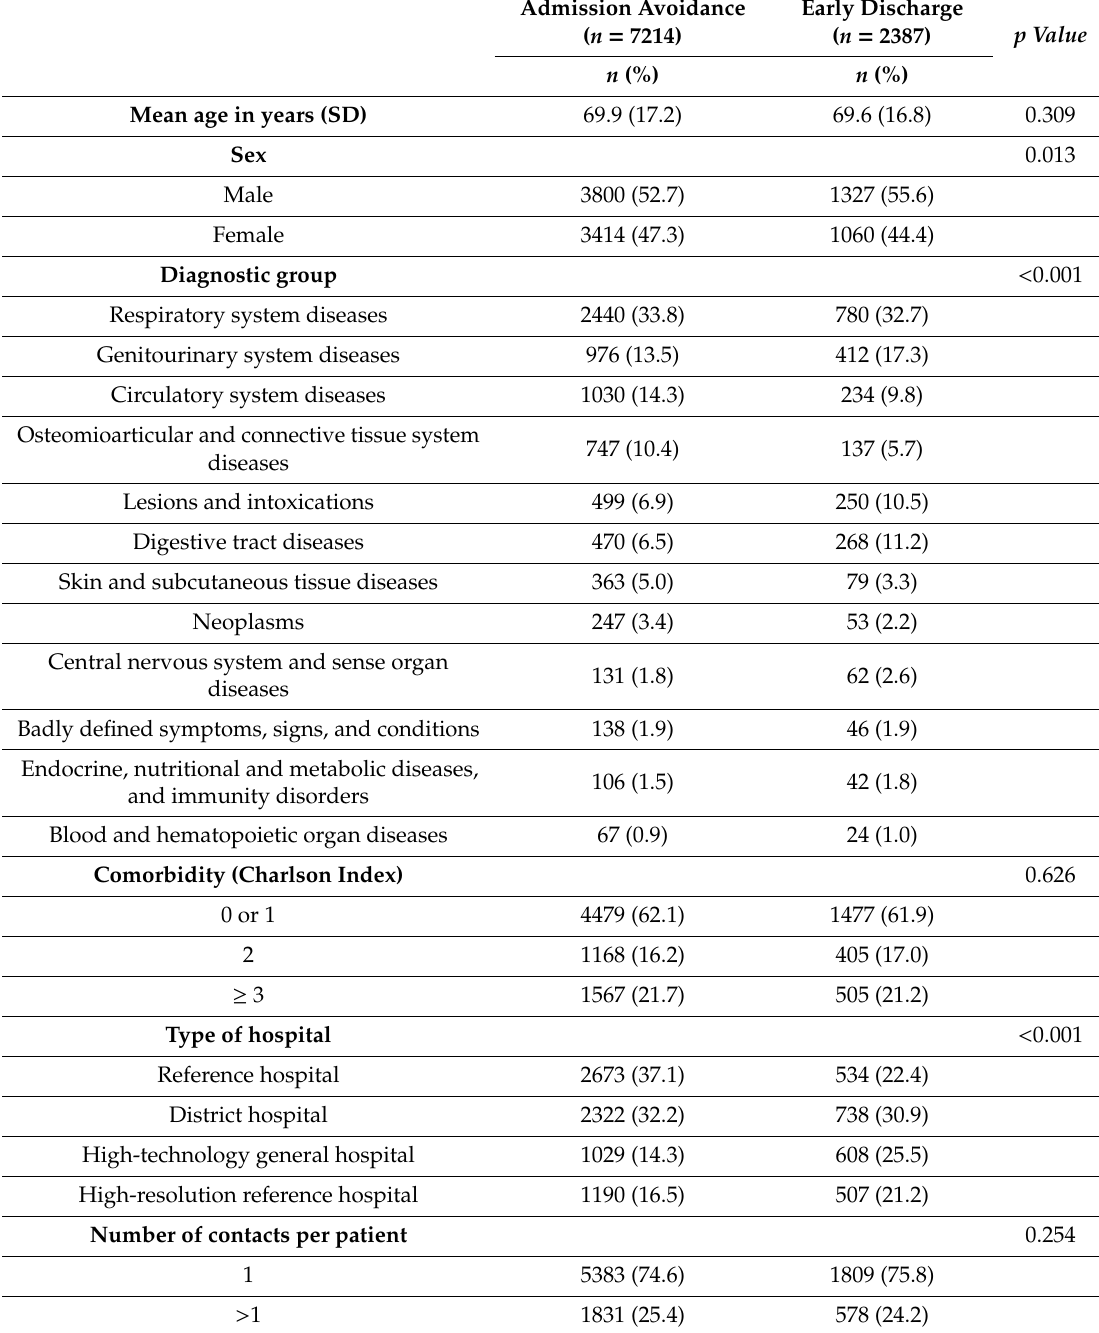
Table 1. Characteristics of the contacts, hospital, and care process according to the hospital-at-home modality. Admission